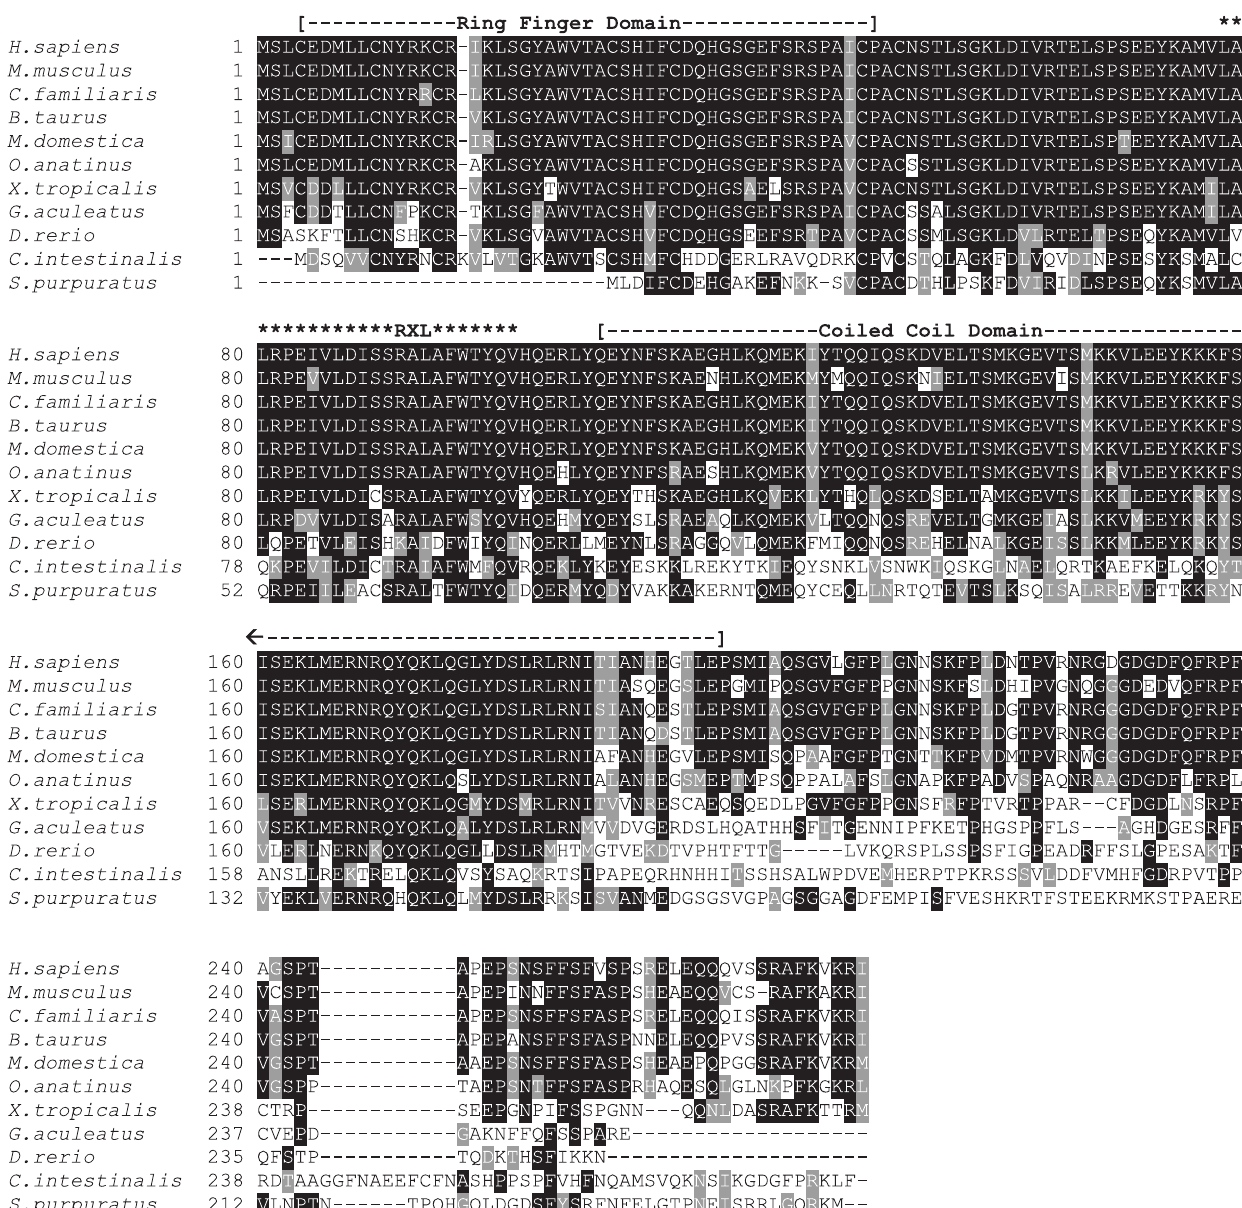
Figure 7. ClustalW Protein Sequence Alignment of HEI10 Orthologs from Deuterostome Lineages Sequence from Homo sapiens (human) and Mus musculus (mouse) have been experimentally determined, while the sequences from Canis familiaris (dog), Bos taurus (cow), Monodelphis domestica (opossum), Ornithorhynchus anatinus (platypus), Xenopus tropicalis (clawed frog), Gasterosteus aculeatus (stickleback fish), Danio rerio (zebrafish), Ciona intestinalis (transparent sea squirt), and Strongylocentrotus purpuratus (California purple sea urchin) were available in databases as predicted proteins (accession numbers are listed below). A candidate RING domain, a potential RXL-type B-type cyclin interaction motif (RAL), the deleted portion of the Hei10 mei4 allele (asterisks), and a central coiled-coil domain are indicated with text above the sequences. Using database and BLAST searches, HEI10 orthologs could not be identified in the chicken, yeast, or in any protostomes such as D. melanogaster or C. elegans .